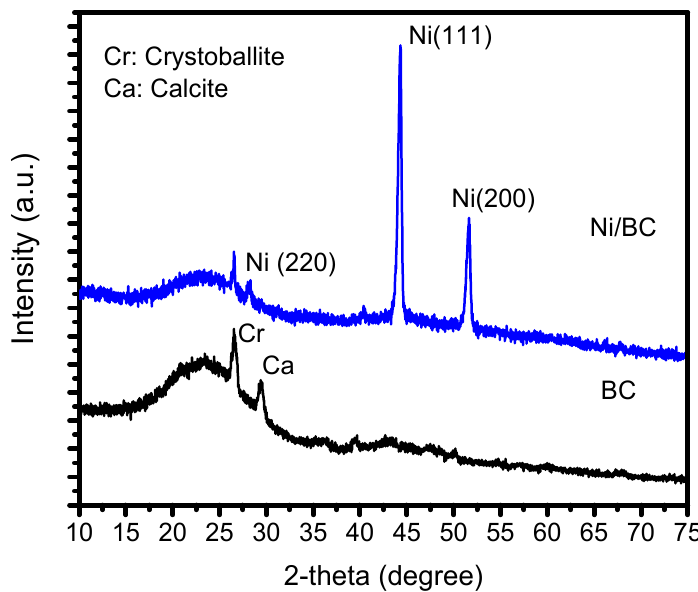
Figure 1. XRD patterns of BC and Ni/BC.